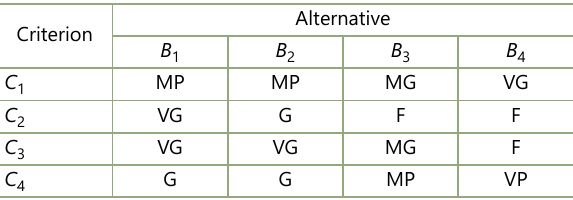
Table 13. The fuzzy decision matrix X G ( l ) (source: own con- tribution)